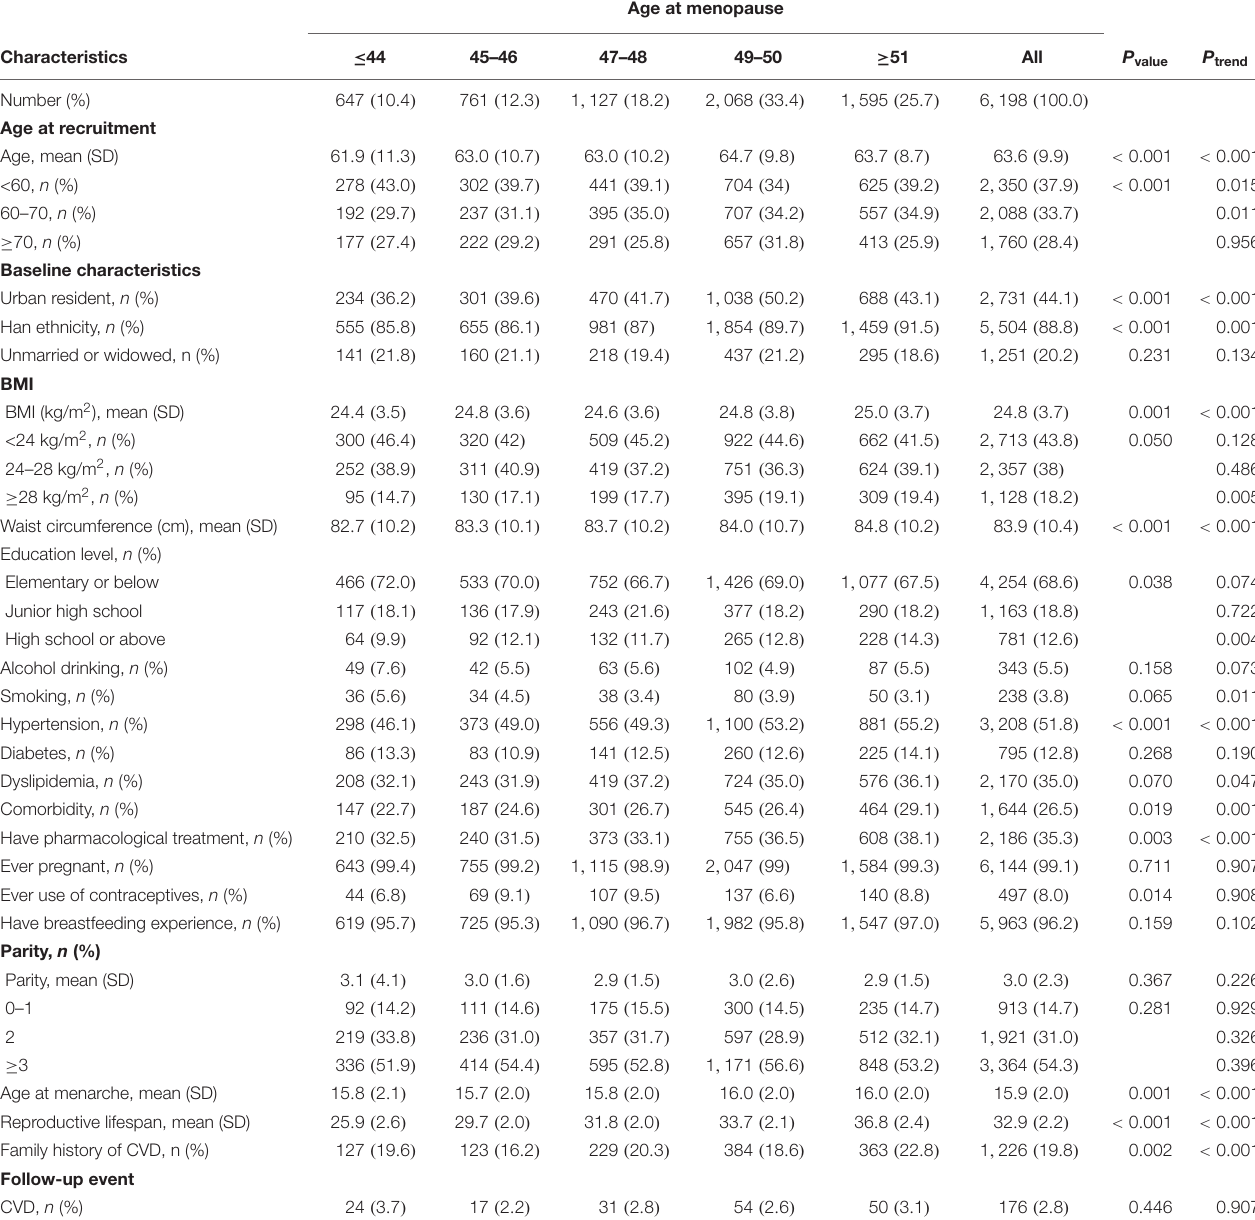
TABLE 2 | Characteristics of study participants by age at